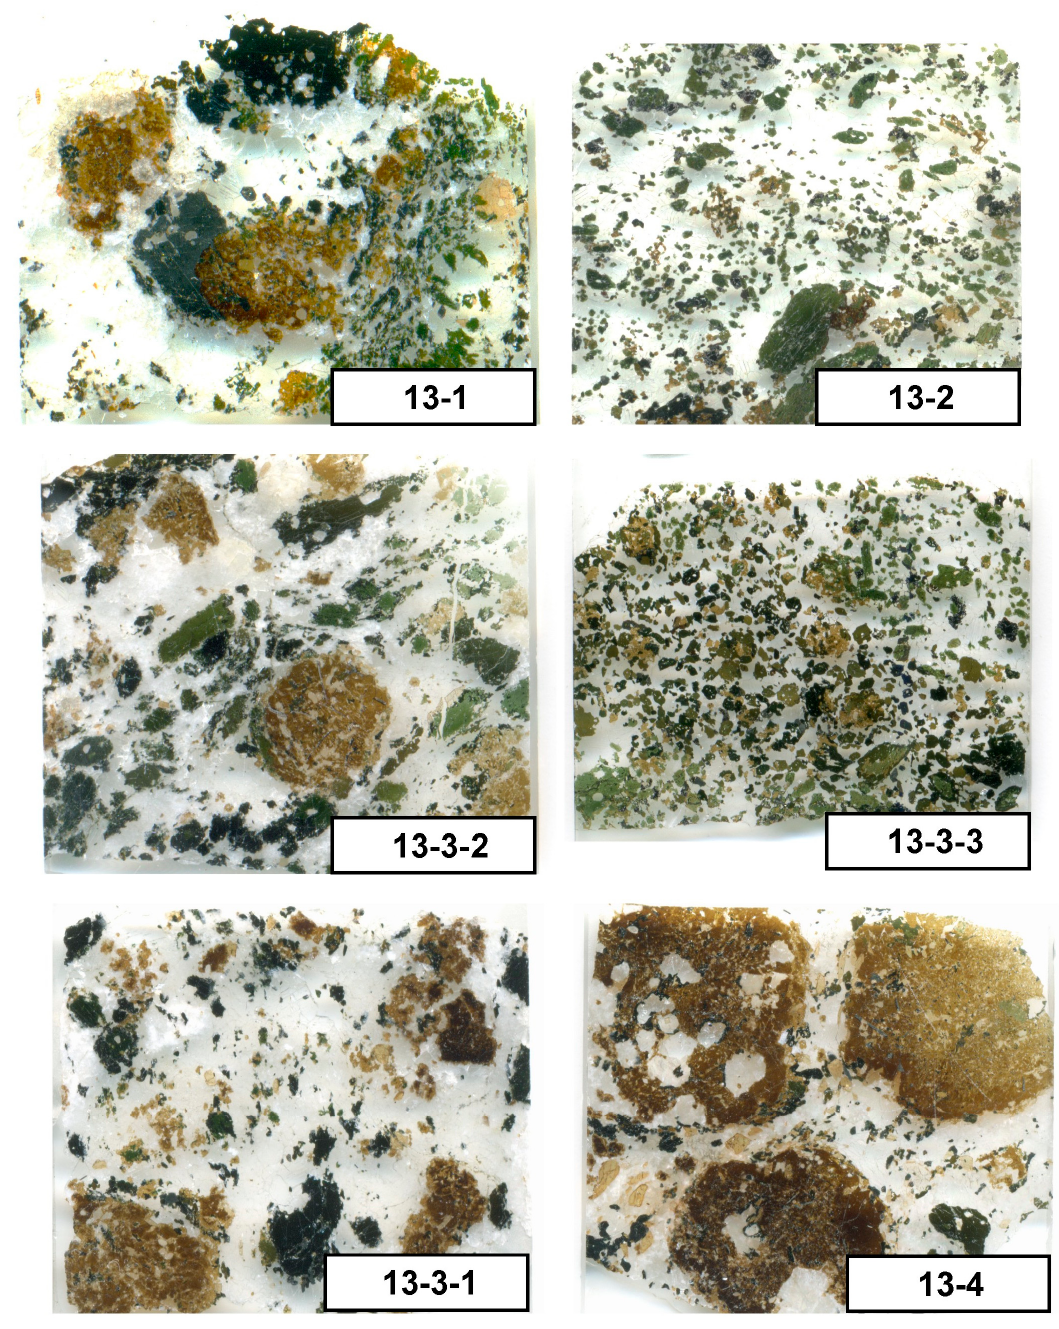
Figure 1. Scans of the selected samples of the Breivikbotn carbonatite, showing extremely heterogeneous textures. Carbonate and zeolite group minerals (white and transparent) form the groundmass; garnet (dark brown) forms rounded poikilitic grains; titanite (yellow) forms small angular and elongated euhedral crystals, pyroxene (greenish) forms subhedral and euhedral crystals, amphibole (bluish, dark-green, and indigo) forms anhedral grains and large laths. Width of all of the scans is about 2.5 cm.